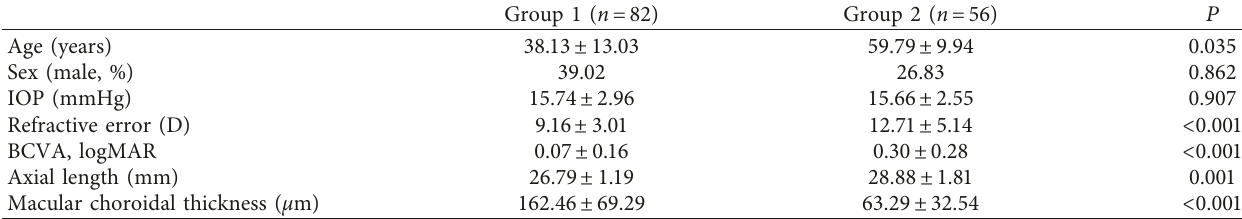
Table 1: Comparison of demographic and clinical data and retinal vessel density in patients with early dry-type myopic maculopathy.